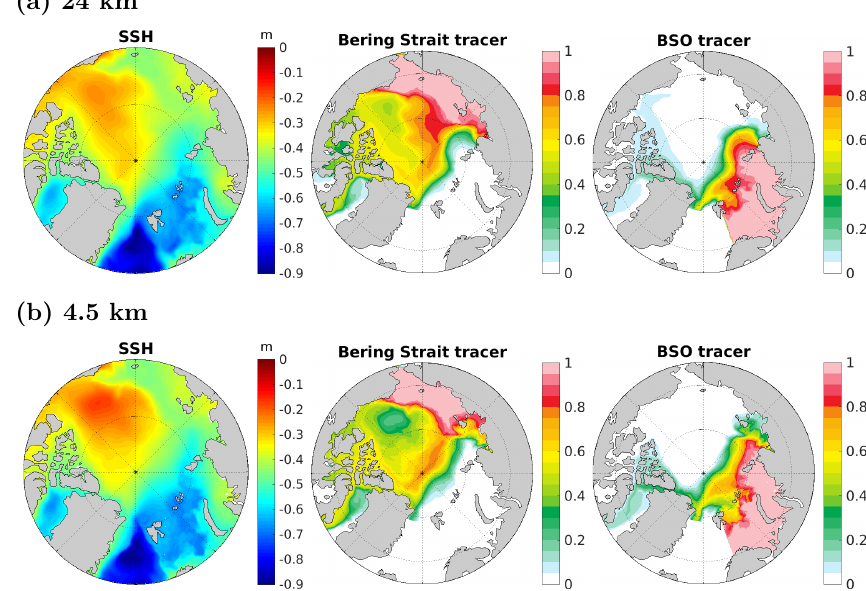
Figure 11. (a) Mean sea surface height (left), Bering Strait passive tracer (middle), and BSO passive tracer (right) in simulation LOW for the period of 1993–2002; for this period, the mean state of FW content is shown in Fig. 10a–c. (b) The same as panel (a) but in simulation HIGH. Note that the passive tracers are set to zero south of the Fram and Davis straits in the plots. The passive tracers are averaged over the upper 100m.